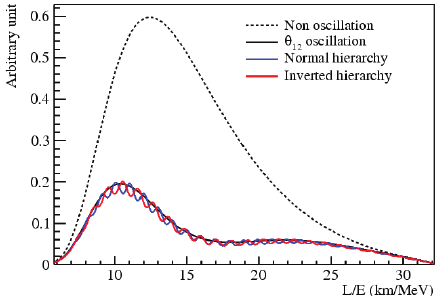
Figure 4. The expected significance of measurement of CP violation in Hyper- Kamiokande (denoted as HK) and DUNE as a function of running time. The normal mass π/ 2, are assumed. T2K and hierarchy, δ CP = − NO ν A experiments are also